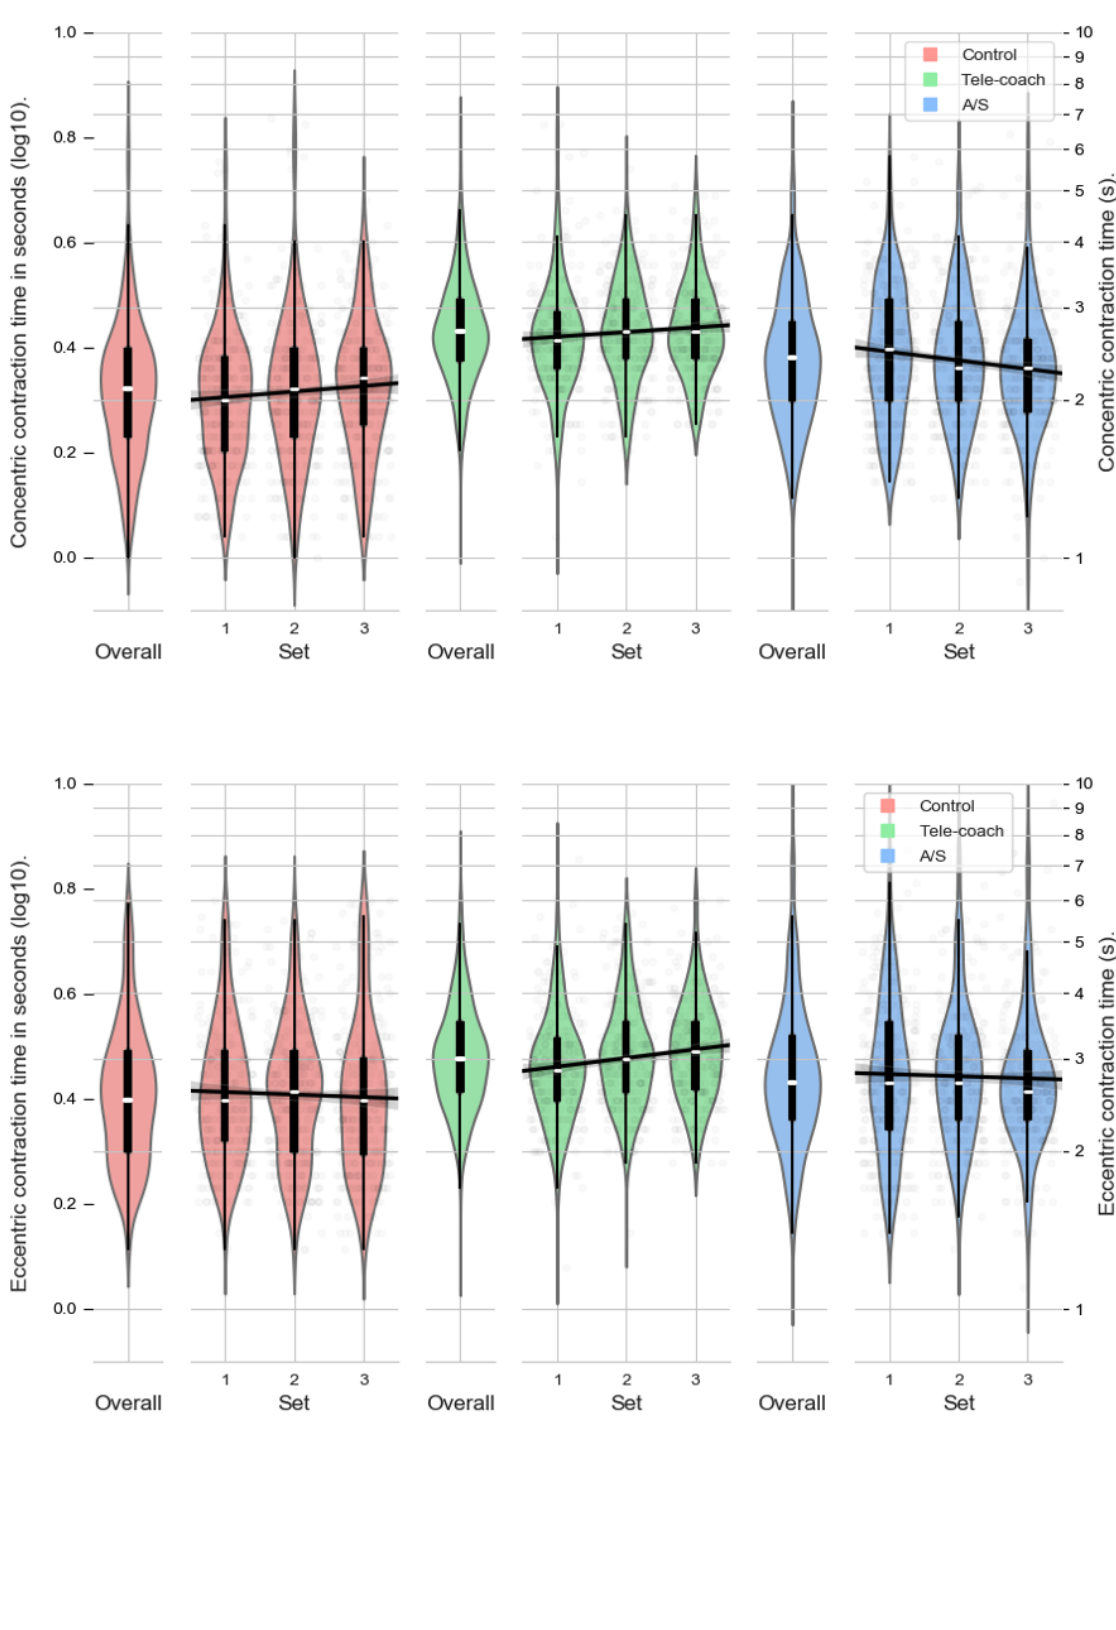
Figure 5. Distributions of concentric (top) and eccentric (bottom) contraction times, colored by condition, and reported per set. A/S: ambient light and